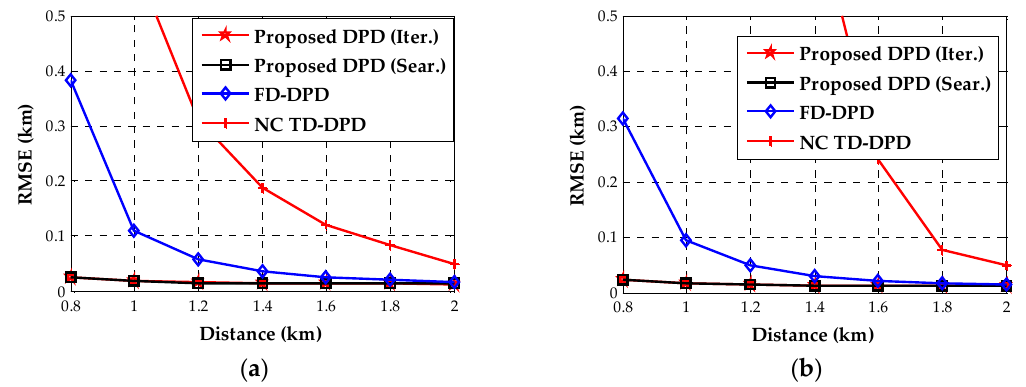
Figure 6. The estimated RMSEs for different distances of near-field sources. ( a ) Source 1; ( b ) Source 2.